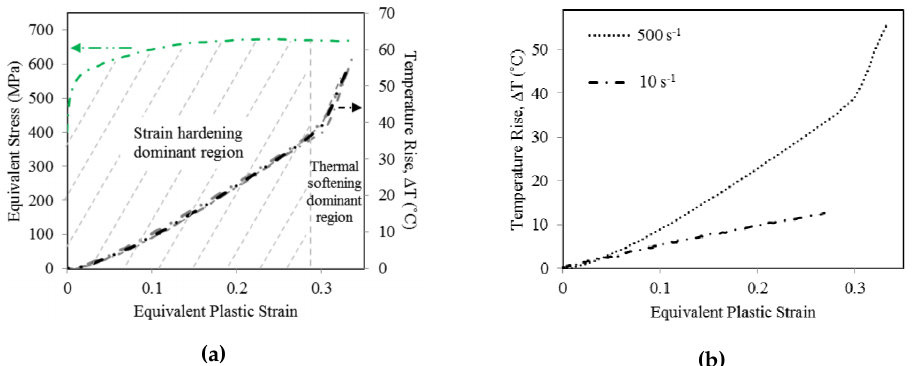
Figure 7. ( a ) Correlation between the measured temperature field and the stress-strain curve in a shear test performed at a strain rate of 500 s − 1 . ( b ) Difference between the temperature fields measured during two shear tests at different strain rates